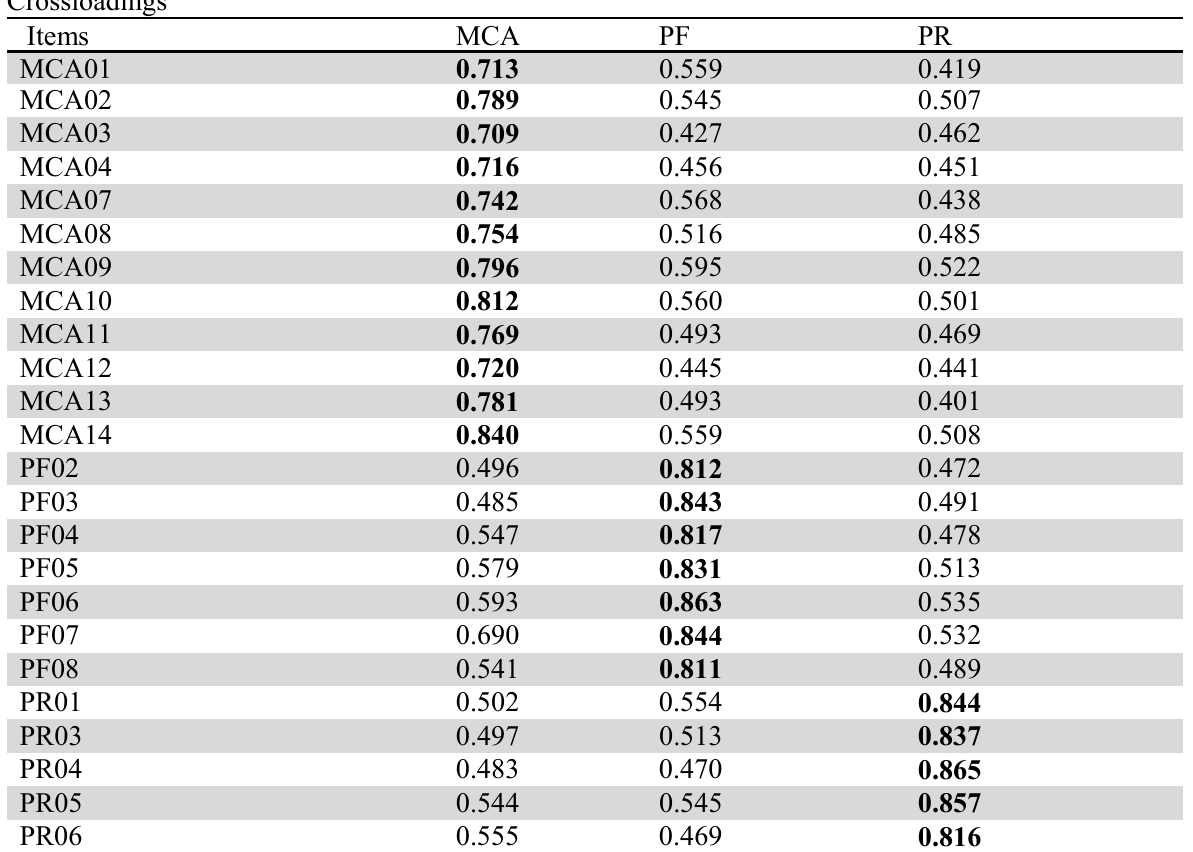
Heterotrait-Monotrait Ratio (HTMT) Construct